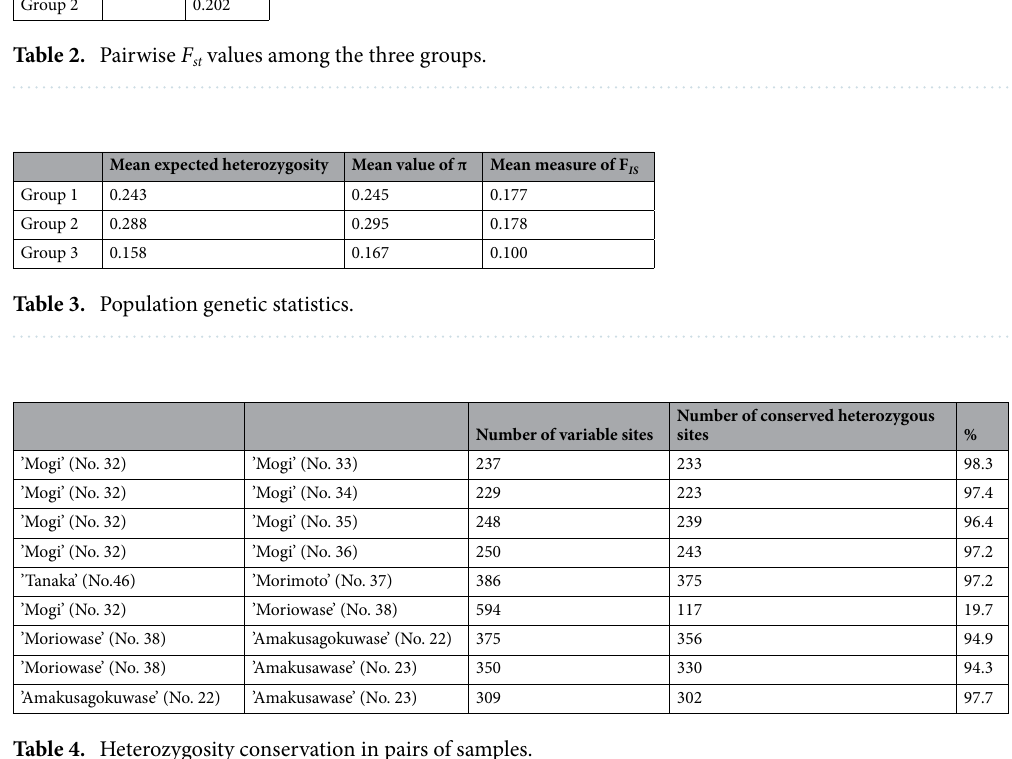
Table 4. Heterozygosity conservation in pairs of samples.